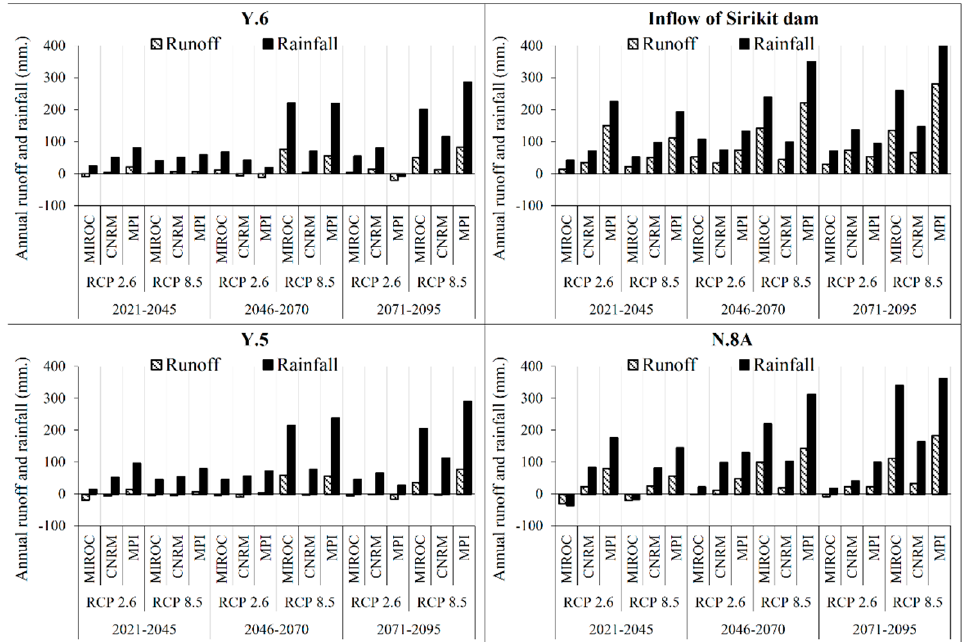
Figure 7. Changes in average annual rainfall and runoff in the reference period (1981–2005) with the near future, intermediate future, and far future under scenarios RCP 2.6 and RCP 8.5.